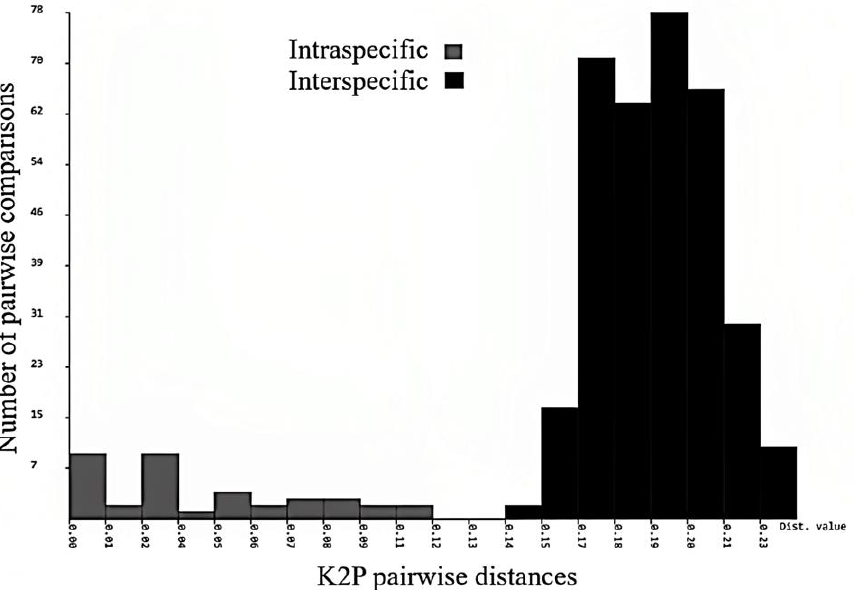
Figure 17. ABGD analysis showing a clear barcode gap in Megascolex species (X axis = genetic distances Y axis = frequency).